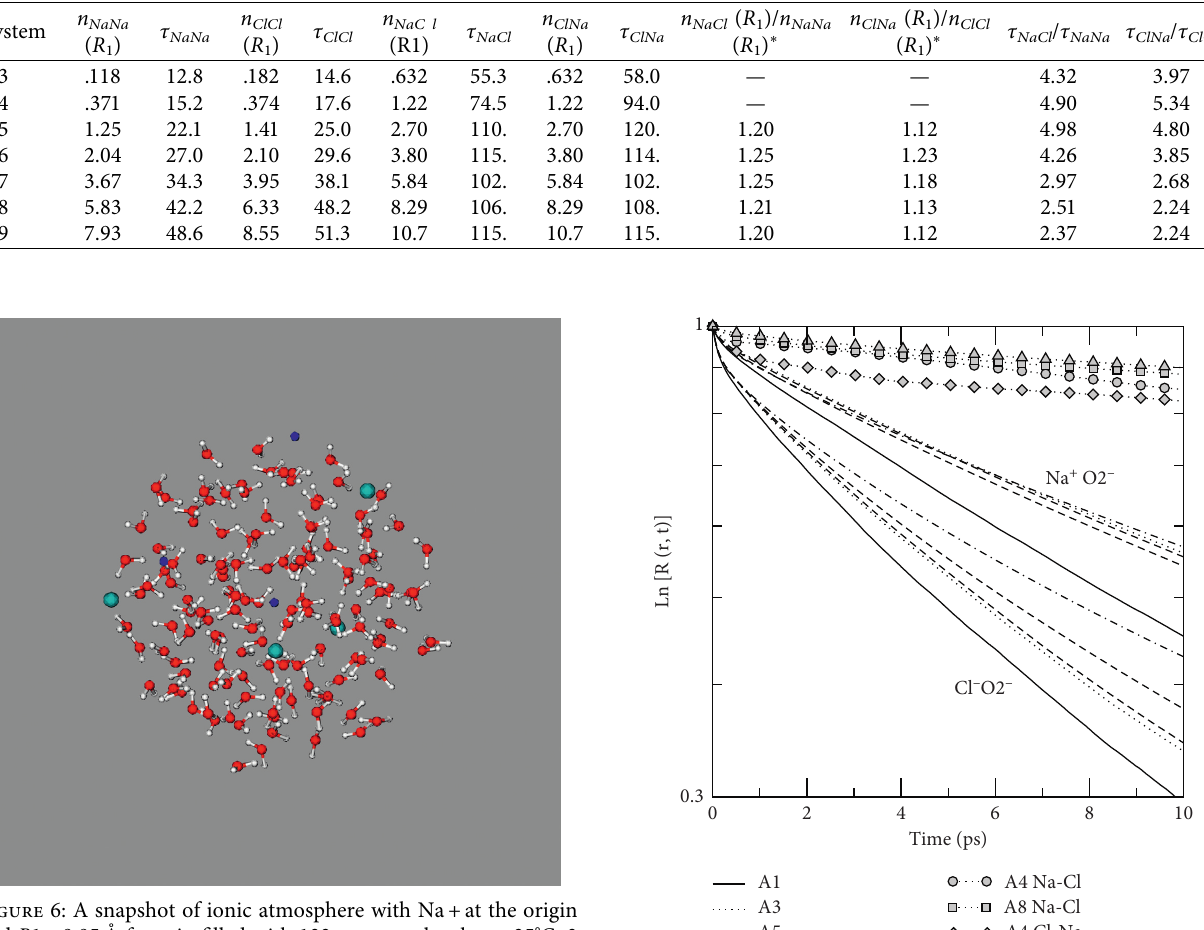
(Table 6). This correction for D